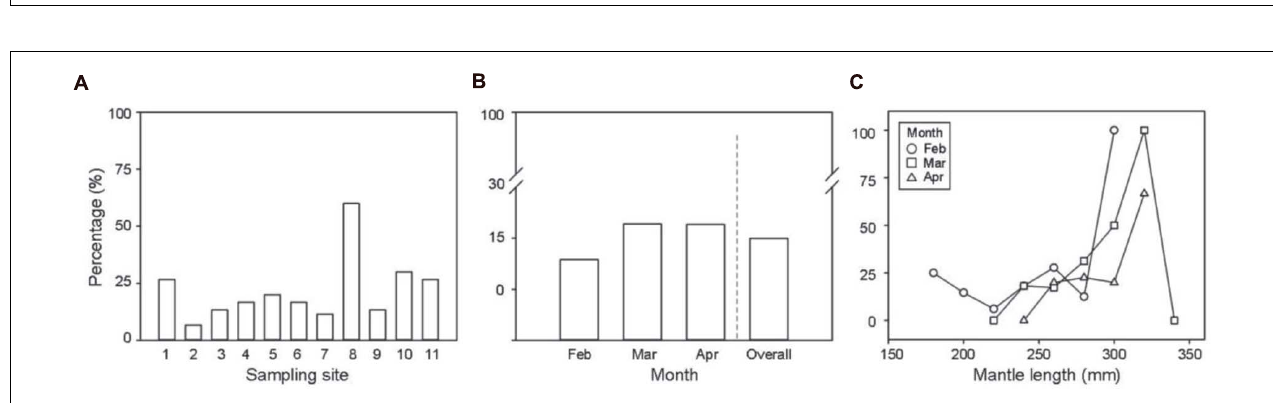
FIGURE 5 | (A–C) Photographs showing examples of different colors, sizes, and shapes of artifacts found in the stomachs of the Argentine shortfin squid Illex argentinus from the Southwest Atlantic. The inset scale bars denote 0.1 mm for each photo.